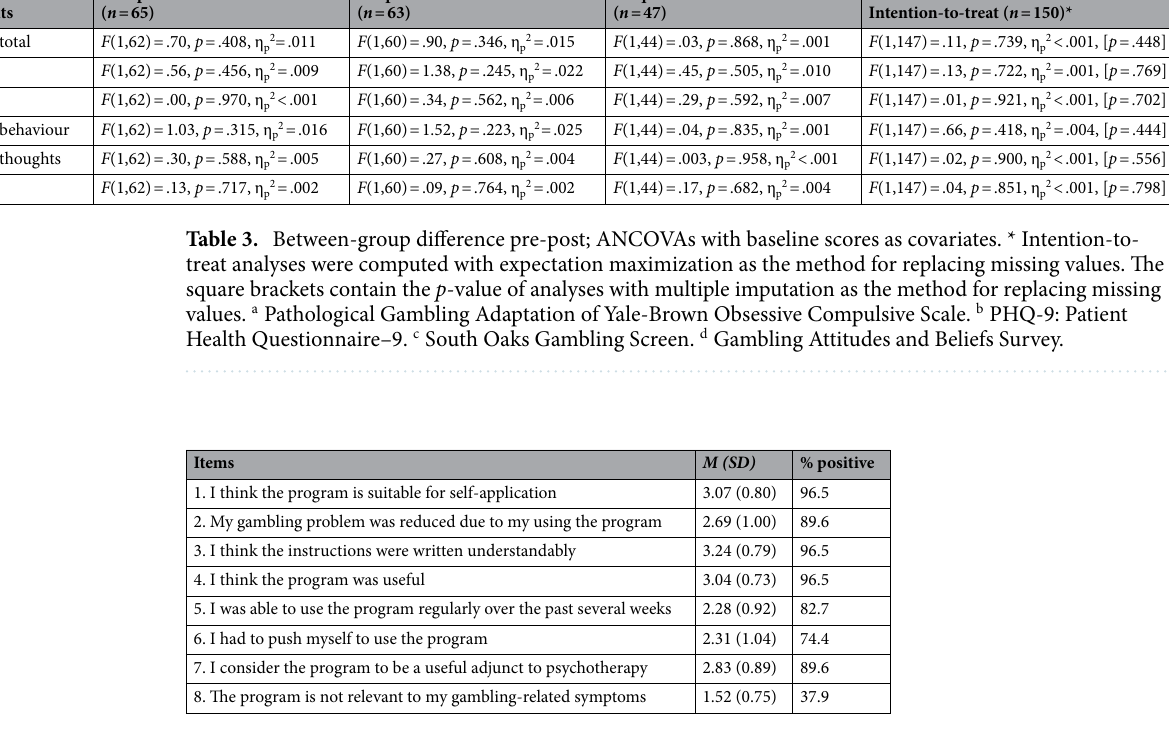
Table 4. Subjective appraisal of Restart ( n = 29). Answers were given on a 4-point rating scale; 1 = not true at all, 2 = somewhat true, 3 = mostly true, 4 = completely true.